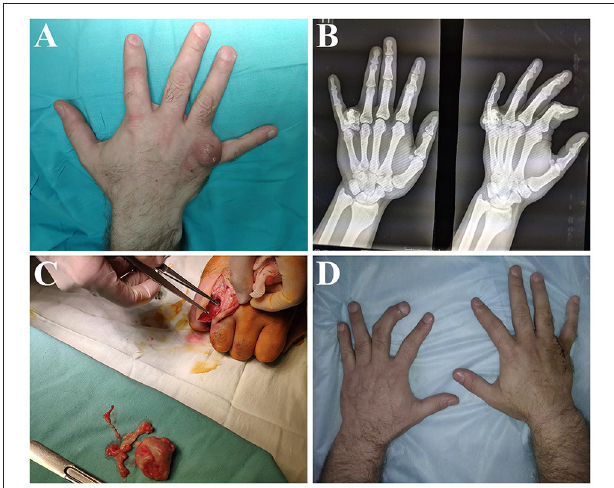
FIGURE 1 | Diagnostics and surgical treatment. (A) Macroscopic observation of the hand on admission: a round infiltrated formation with a fistulous opening was located at the base of the ring finger. (B) X-ray of the hand on admission: an enchondroma with an heterogenous structure was visualized at the base of the proximal phalanx. (C) Intraoperative macroscopic revision of necrotic bone and soft tissues. (D) Macroscopic observation of the hand upon discharge from the hospital: wound healed by primary intention.